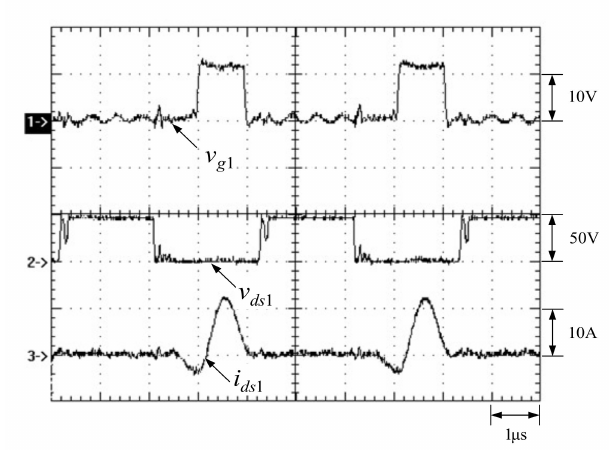
Figure 12. Waveforms relevant to S 1 : (1) v g 1 ; (2) v ds 1 ; (3) i ds 1 .